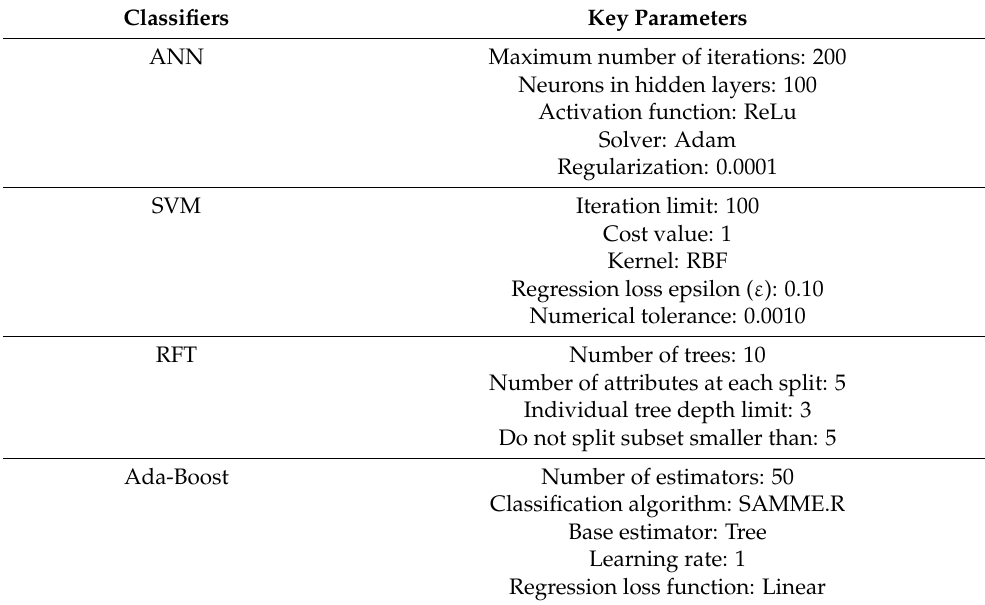
Table 1. Key parameters of the hand gesture learning